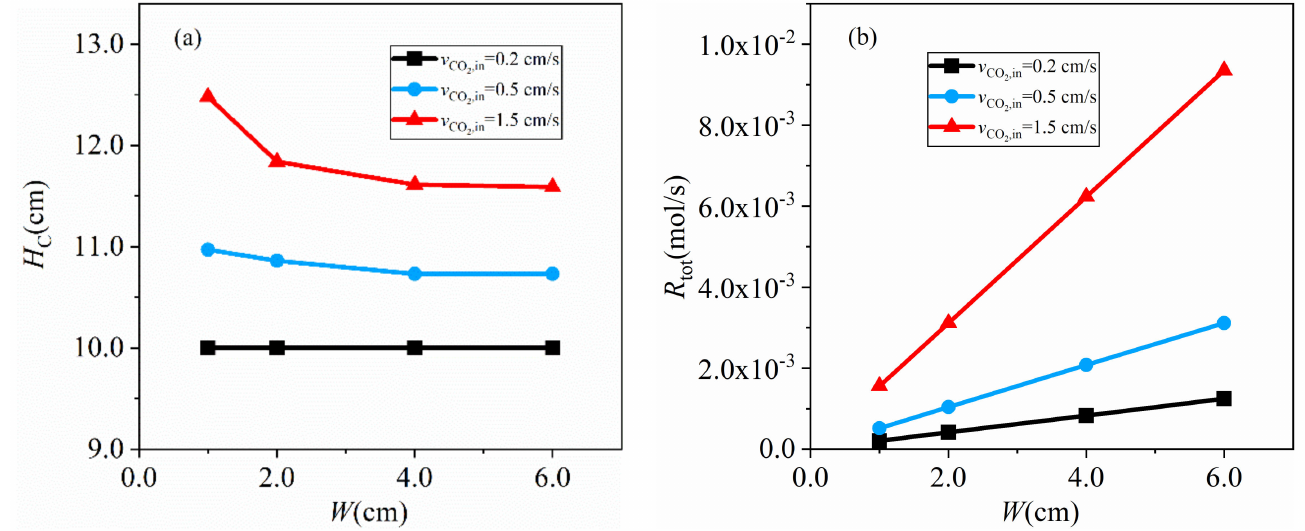
Figure 6. Effect of channel width, W , and inlet velocity v CO on ( a ) carbon bed height, H C , ( b ) total gasification rate, R tot . 2 ,in As shown in Figure 6, R tot increases with channel width linearly, while the ef- fects on bed height, H C , varies with the gas–solid flow regime. For the fixed bed with v CO = 0.2 cm/s, H C keeps the initial bed height; for the delayed bubbling bed with 2 ,in v CO = 0.5 cm/s, H C decreases with increasing channel width slightly, indicating that 2 ,in